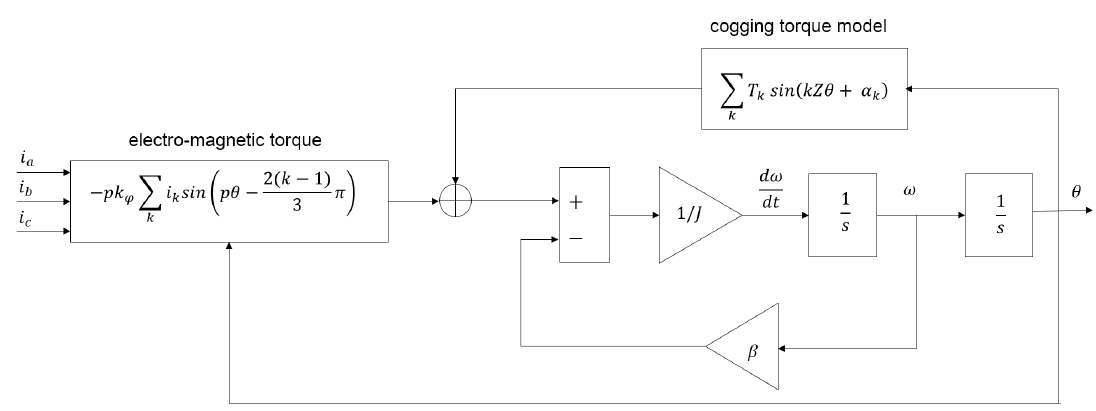
Figure 7. Block diagram of the mechanical equilibrium.